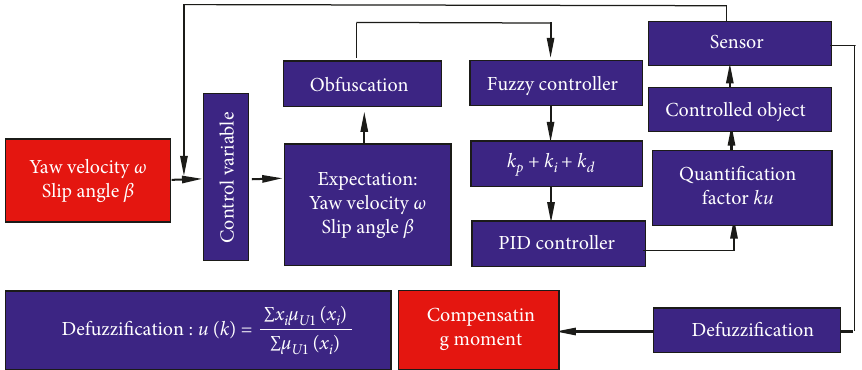
Figure 5: Schematic diagram of fuzzy PID controller.